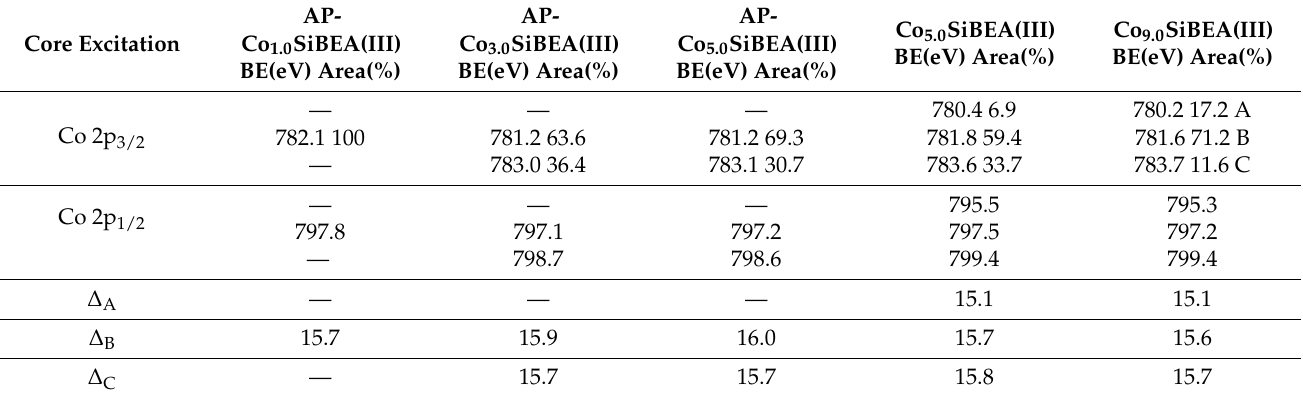
Figure 9. Co 2p XPS spectra of Co x SiBEA (pH = 2.5). Red arrows mark a low-BE component which is not seen in as received samples. Table 2. The BE values (eV) and relative areas of components (%) of Co 2p 3/2 core excitation obtained for Co x SiBEA samples (pH = 3.0–9.0. A, B, and C denote Co 2p components visible in Figure 8. The spin–orbit splitting ∆ (eV) of each doublet is also